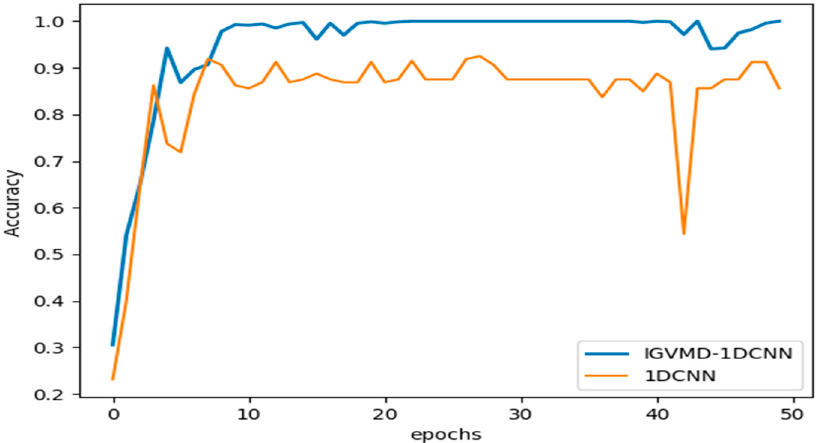
Figure 17. Variation in accuracy with iteration number.